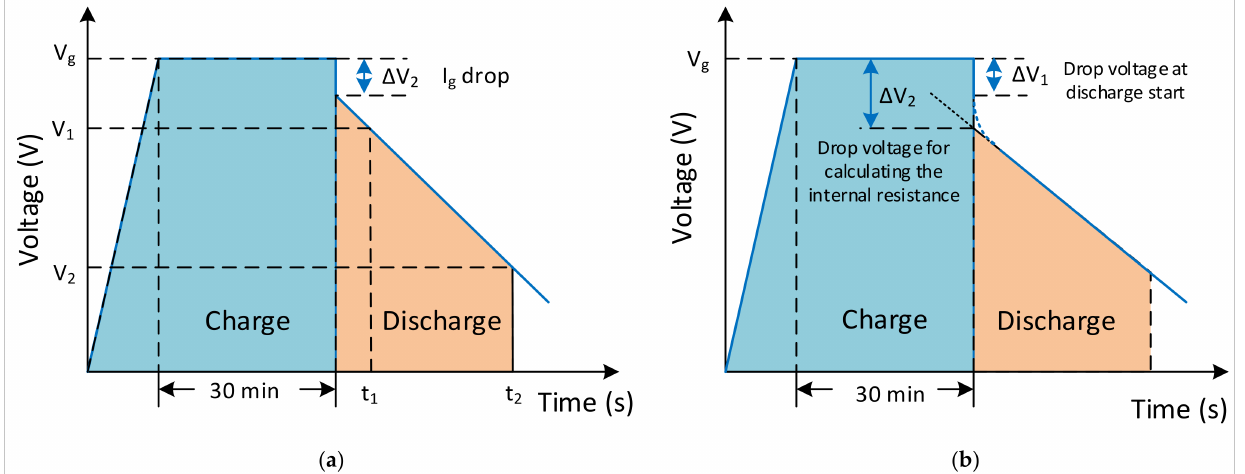
Figure 14. The charge–discharge characteristics for ( a ) measuring the capacitance and ( b ) internal DC resistance measurement